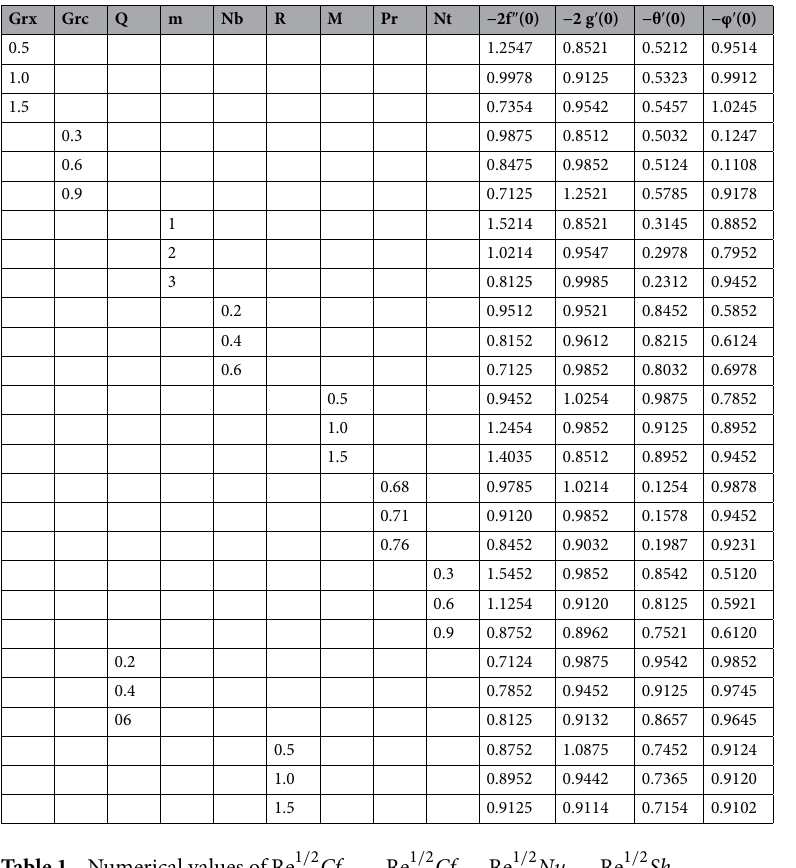
Table 1. Numerical values of Re